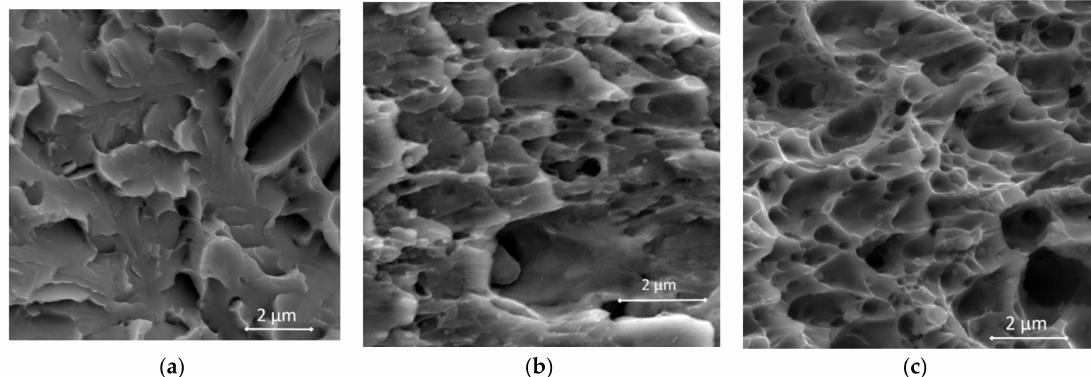
Figure 14. Detail fracture appearance: ( a ) cleavage in LSE region (Air720, − 150 ◦ C); ( b ) ductile fracture in transition region (Air720, − 30 ◦ C); ( c ) ductile dimples in USE (He720, 23 ◦